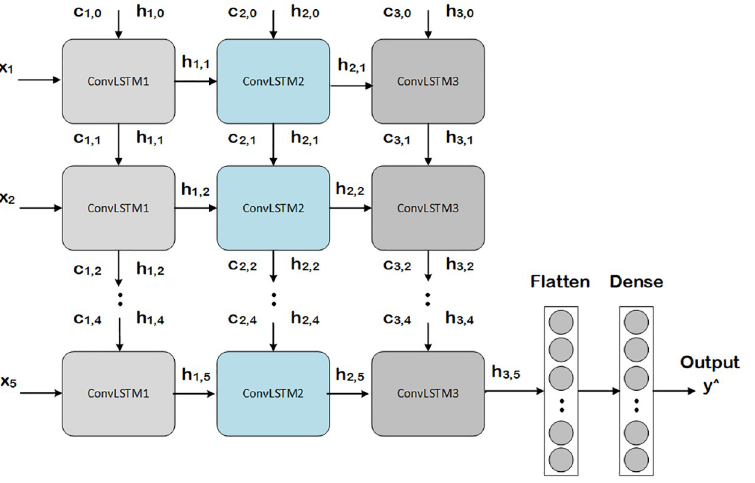
Fig 8. Proposed ConvLSTM model.